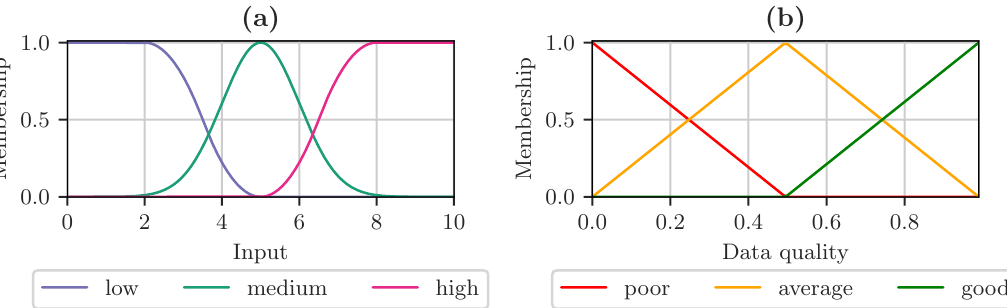
Figure 6. Example membership function for ( a ) an input between zero and ten. Z-shaped membership for low, Gaussian membership for medium, and S-shaped membership for high. ( b ) data quality with trapezoidal membership for poor, average and